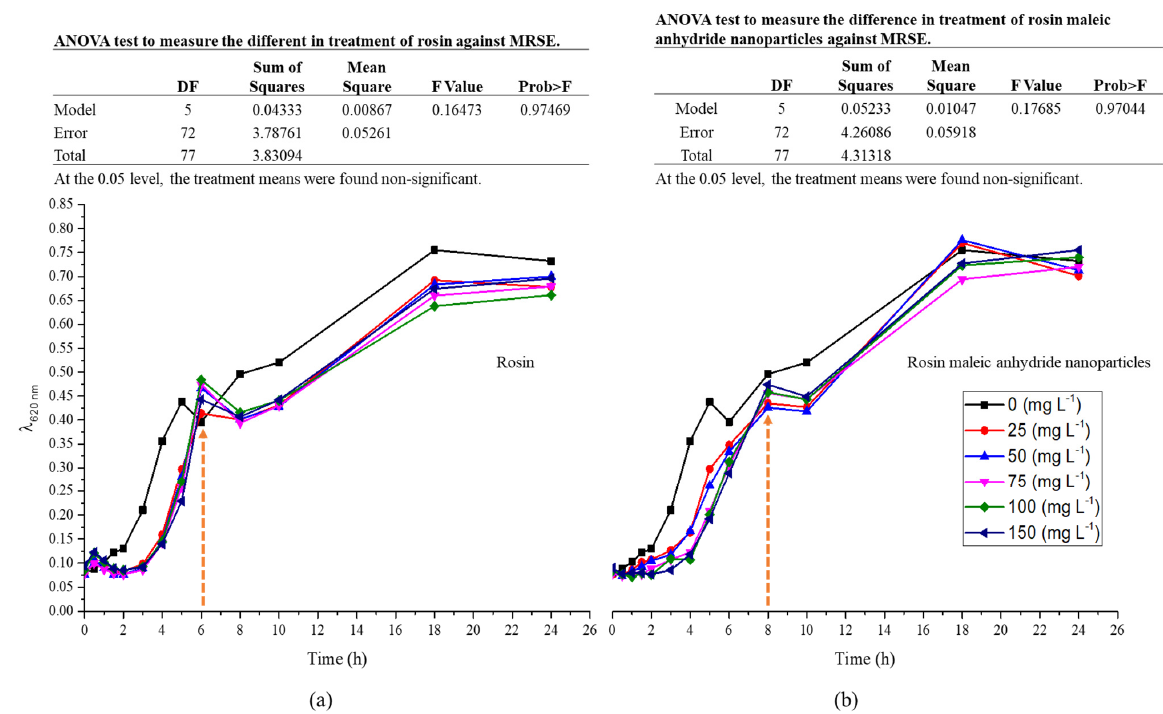
Figure 5. MRSE growth response to treatments: a ) rosin, b ) rosin maleic anhydride nanoparticles.